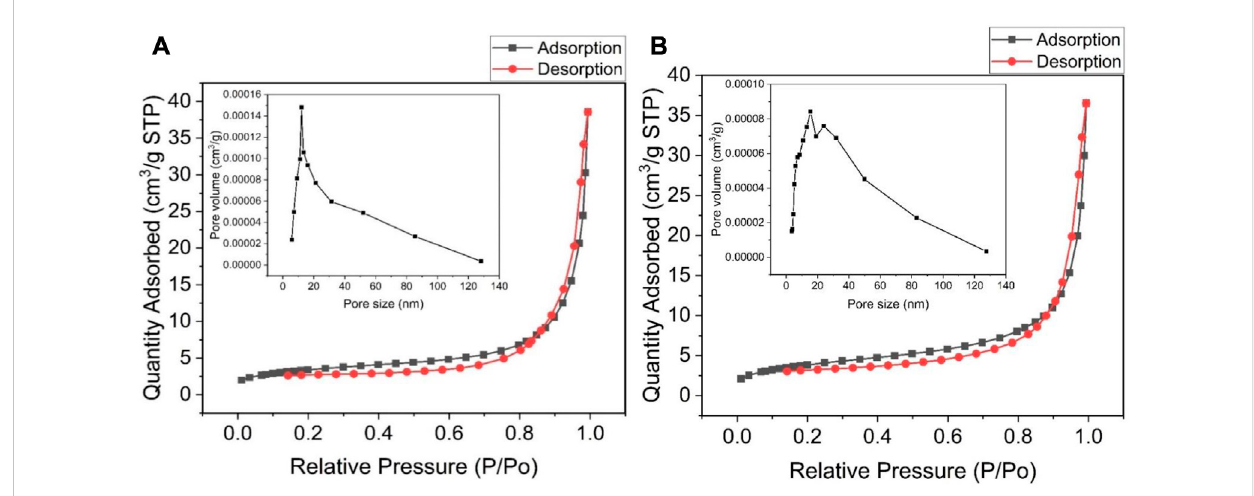
FIGURE 7 Nitrogen adsorption-desorption isotherm of (A) WO 3 -HNO 3 , and (B) WO 3 -HCl, and their corresponding BJH pore size distribution (the insets).